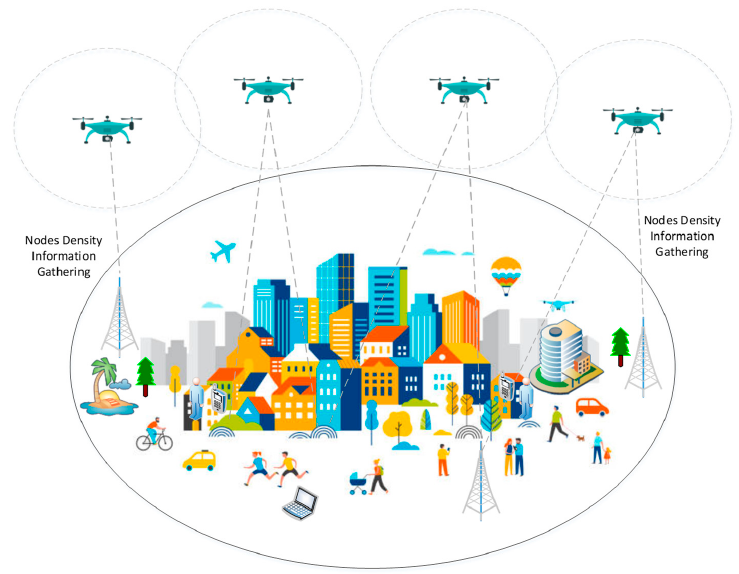
Figure 3. IoT Network Nodes Density Estimation from UAVs Nodes.